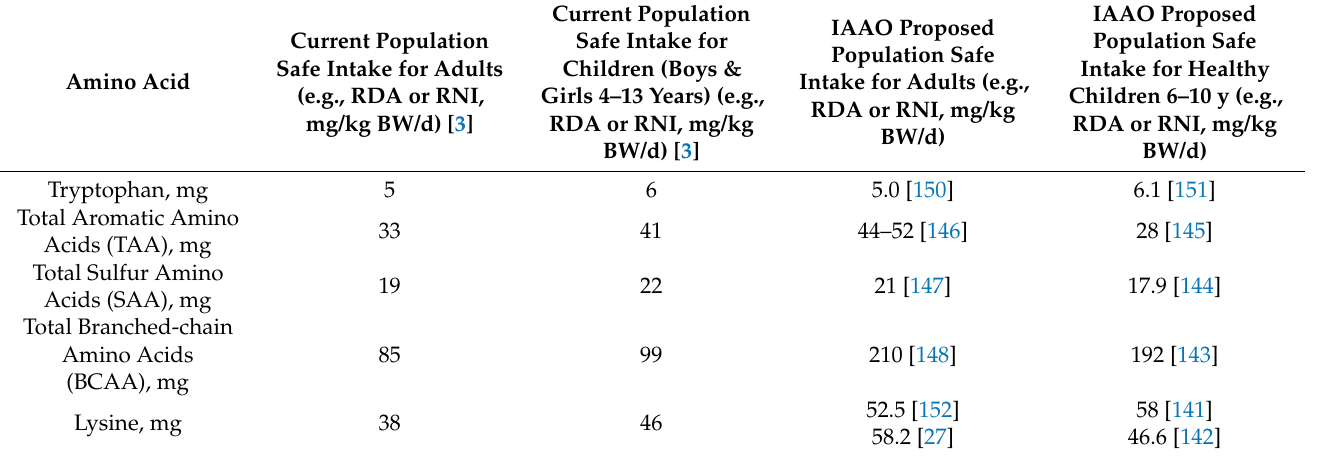
Table 3. Comparison of Adult and Children RDA for Individual Amino Acids and Proposed Popula- tion Safe Estimates from IAAO